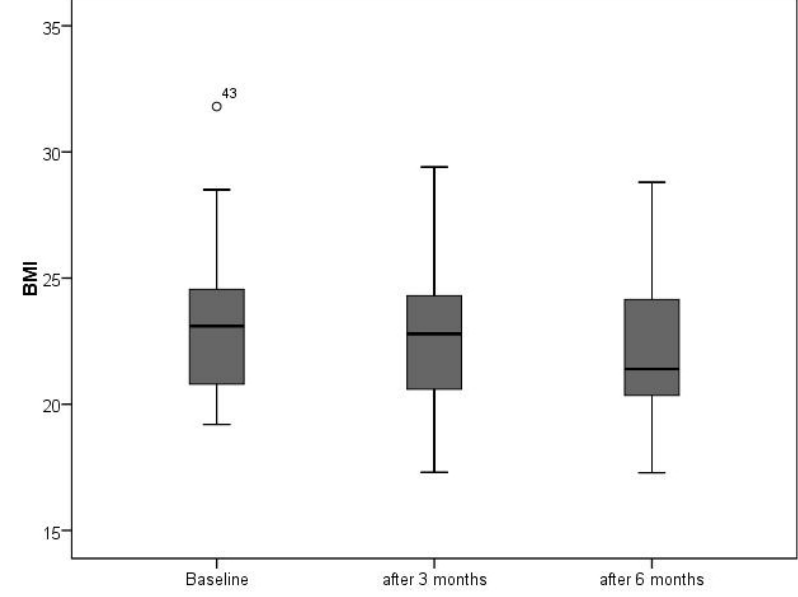
Figure 5. Changes in body weight over the course of 6 months in ALS patients with a CNAQ score >